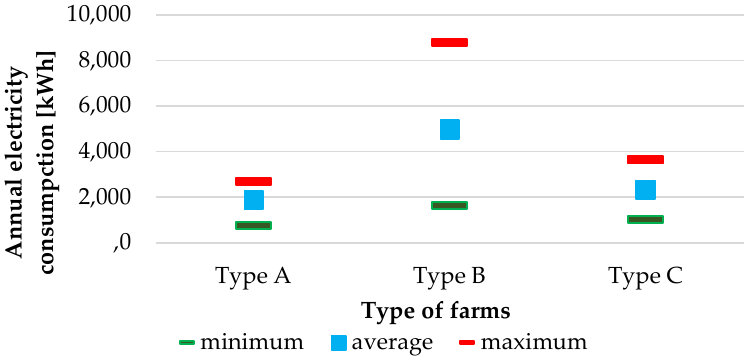
Figure 1. Statistical values of annual electricity consumption related to agricultural production depending on the farm type .